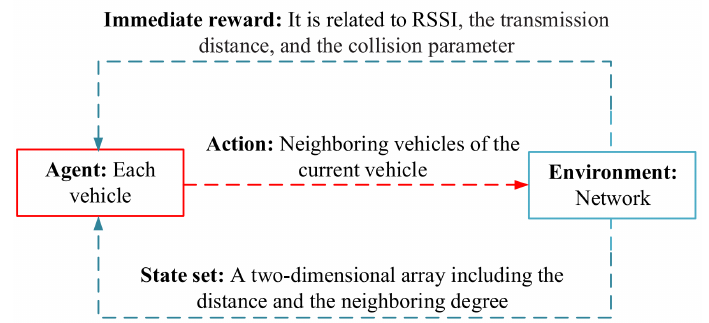
Figure 10. Learning structure in QAGR.